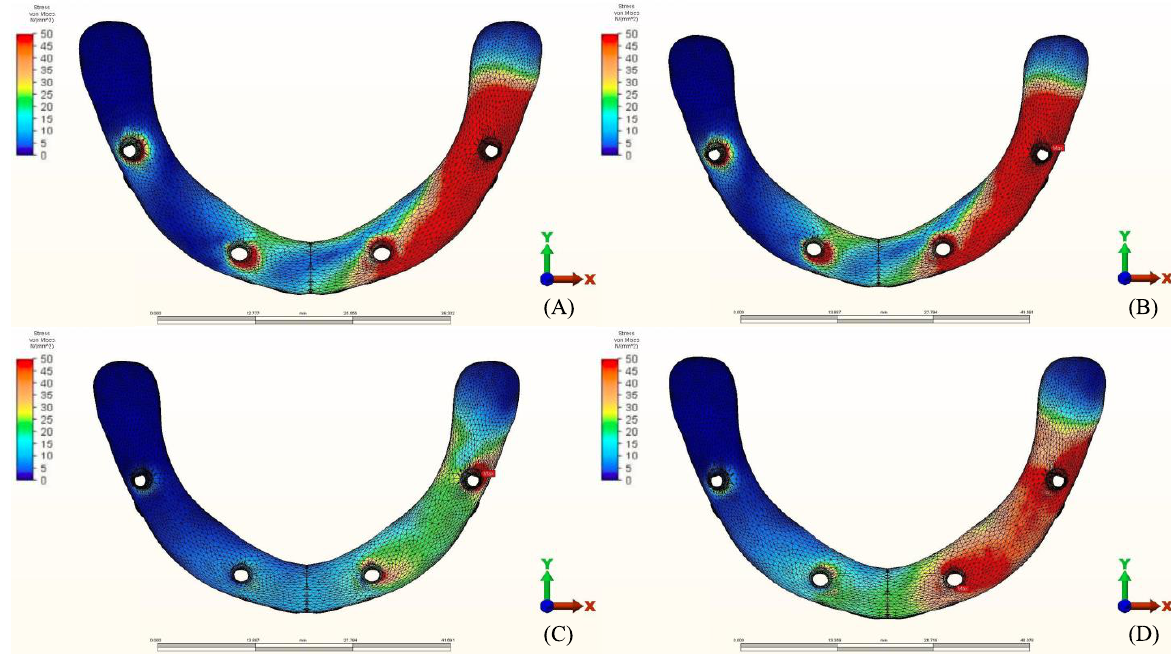
Figure 18. Stress distribution in the framework for group 2, titanium bar with resin composite gingiva and ceramic superstructure with zirconium (Toronto bridge). ( A ) Model 2.1, opposing natural tooth. ( B ) Model 2.2, opposing tooth-supported full ceramic crown. ( C ) Model 2.3, opposing acrylic prosthesis with titanium framework. ( D ) Model 2.4, opposing implant-supported full ceramic crown.